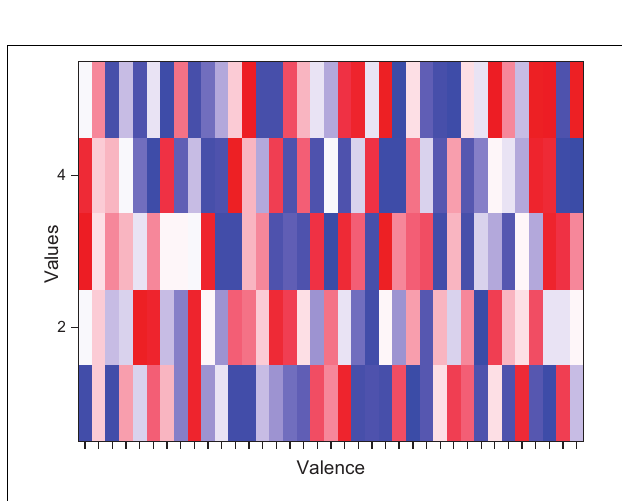
FIGURE 5 | Object valence sentiment correlation